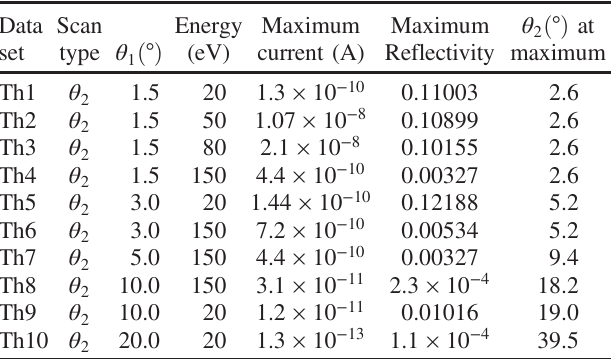
TABLE VI. Table of θ 2 scan data sets, for aluminum sample #1. The out-of-plane angle is fixed at ϕ ¼ 0 .